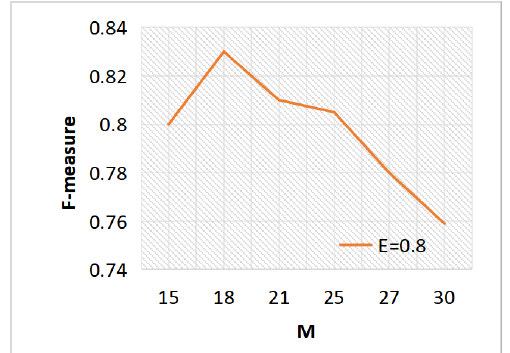
Figure 6. The impact of M